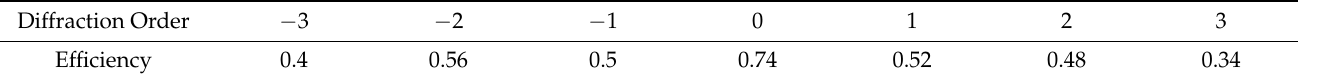
Table 2. Diffraction efficiency of the DMD.